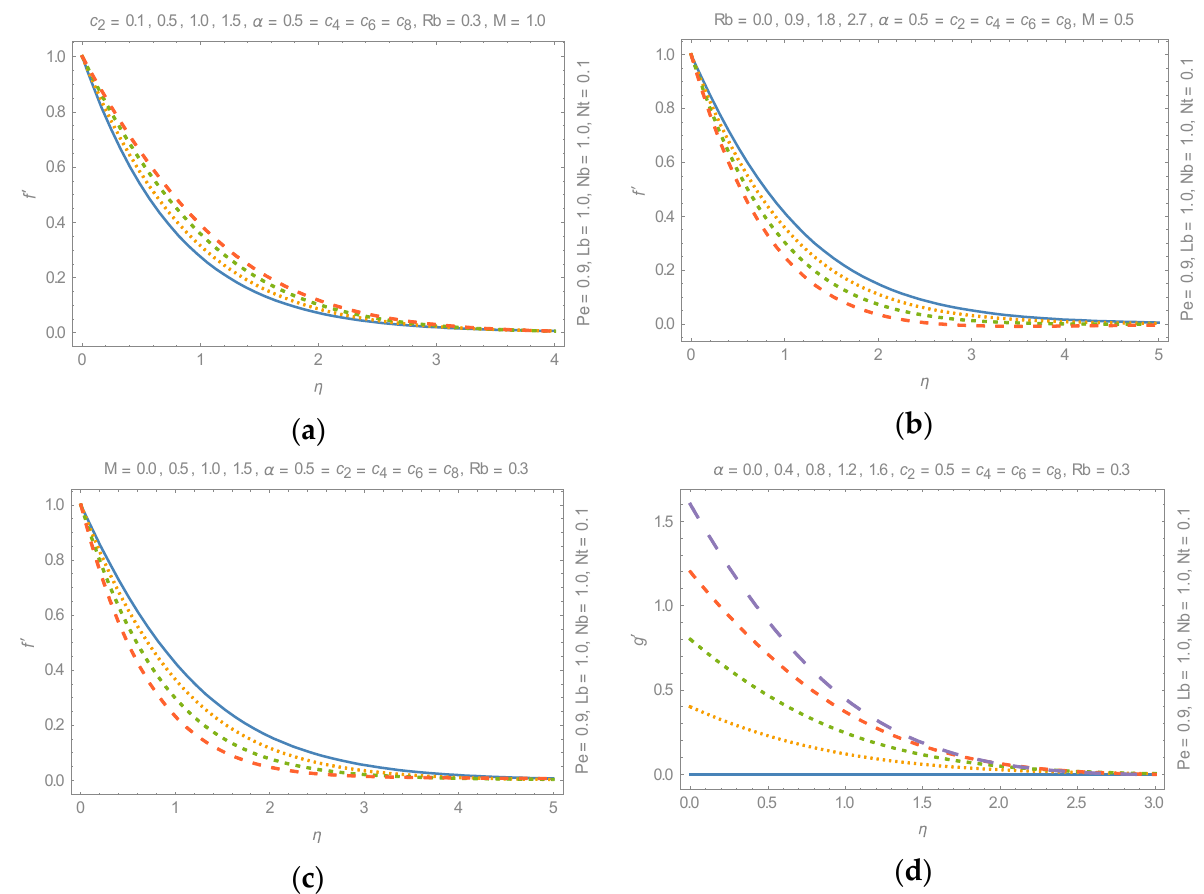
Figure 3. Behavior of ( a ) f (cid:48) ( η ) for c 2 , ( b ) f (cid:48) ( η ) for Rb , ( c ) f (cid:48) ( η ) for M , and ( d ) g (cid:48) ( η ) for α .